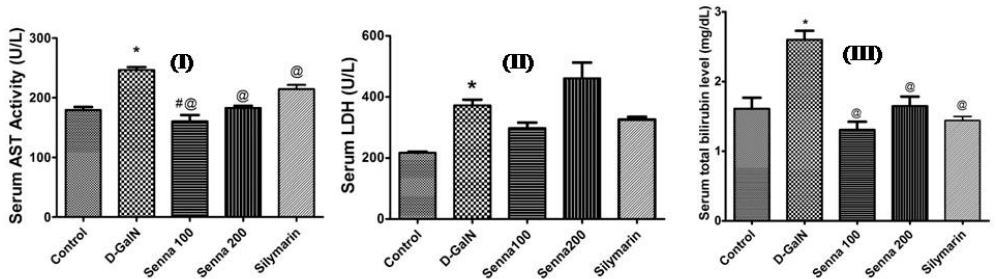
Figure 4. Effect of D -GalN (800 mg/kg, i.p.), bark extract (100 mg/kg and 200 mg/kg, oral), and silymarin on ( I ) AST (aspartate aminotransferase); ( II ) LDH (lactate dehydrogenase) activities ( III ) total bilirubin. Results are presented as mean ± SE. * significantly different compared to